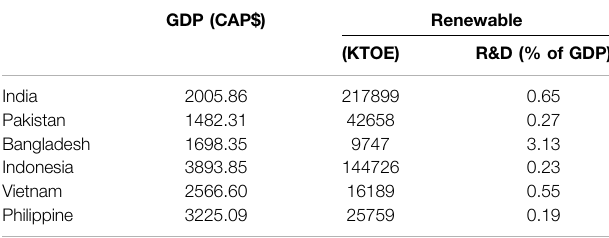
TABLE 1 | Score of positive indicators in South-East